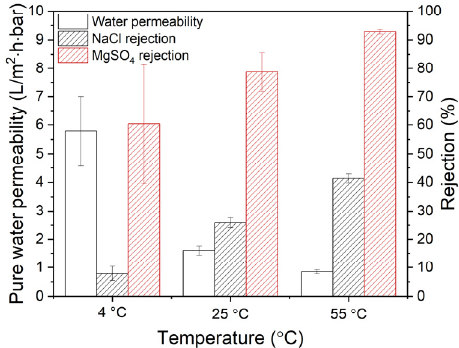
Figure 8. Effect of coating temperature (dopamine concentration: 2.0 g/L) on the UPW permeability and rejection of NaCl and MgSO 4 . Rejection is measured with a salt concentration of 2 g/L at 5 bar. Average values and standard deviations represent at least four (UPW permeability) and two (rejection measurements) measurements, respectively.